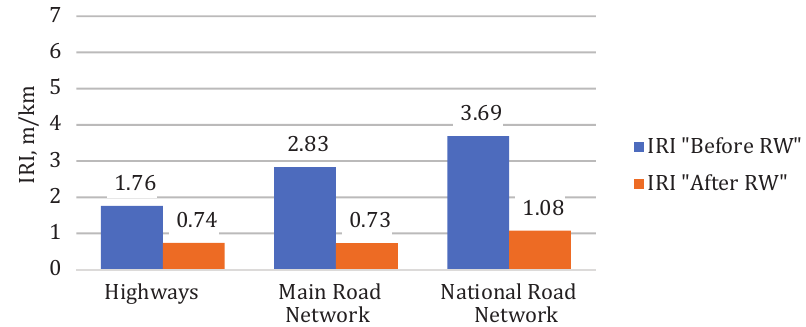
Figure 4. Change in IRI after renewal of the bearing capacity (in